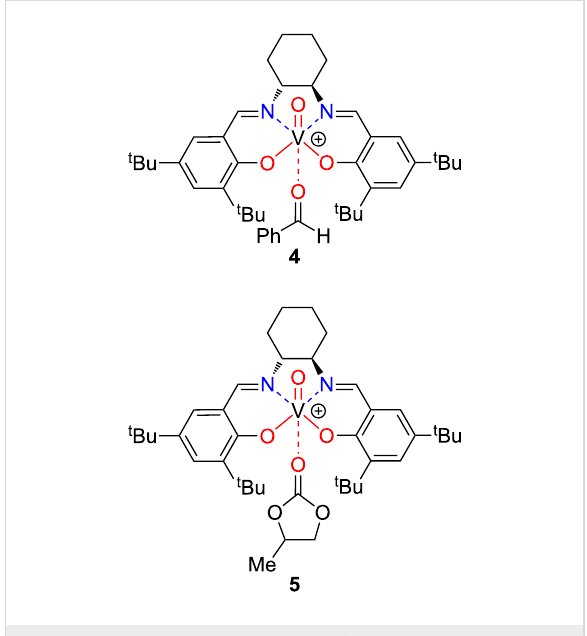
Figure 6: Structures consistent with the 51 V NMR spectra.